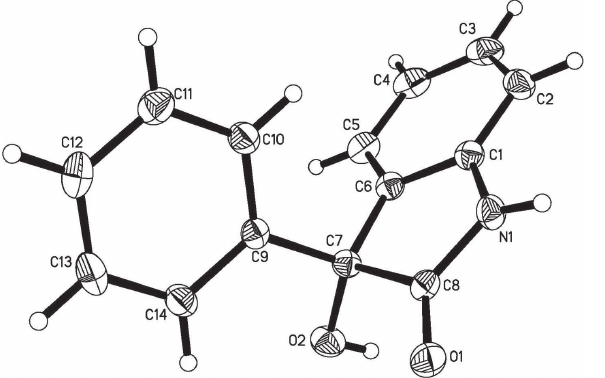
Table 1: Data collection and handling.